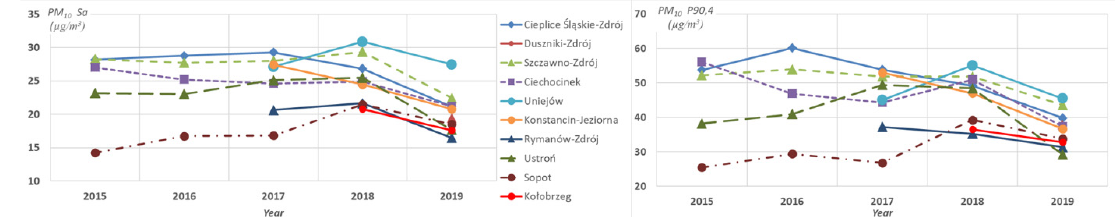
Figure 2. The values of average annual concentrations (Sa) and the 90.4 percentile for the examined spas in 2015–2019 (Source: own study based on SEM data [30]).